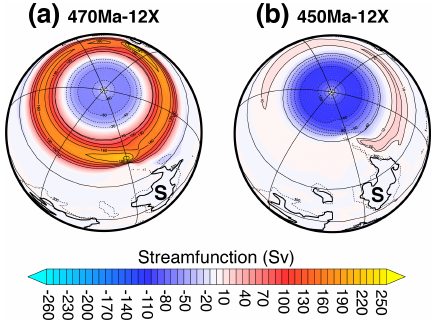
Figure 8. Siberia’s northward drift and the consequences on the lon- gitudinal stream function. Eastward stream is positive (red), west- ward stream is negative (blue). The stream function is integrated over the whole water column. S: Siberia. Simulations were con- ducted with the fully coupled version of FOAM. It is noteworthy that the northward drift of Siberia from the Middle to the Late Or- dovician is a robust feature of all available Ordovician paleogeo- graphical reconstructions published so far, including the maps from Torsvik and Cocks (Cocks and Torsvik, 2007, Fig. 6a; Torsvik and Cocks, 2013: Fig. 2.12, 2.14 and 2.15), Golonka and Gaweda (2012, Figs. 6 and 7) and Scotese and McKerrow (1991, Figs. 4 and